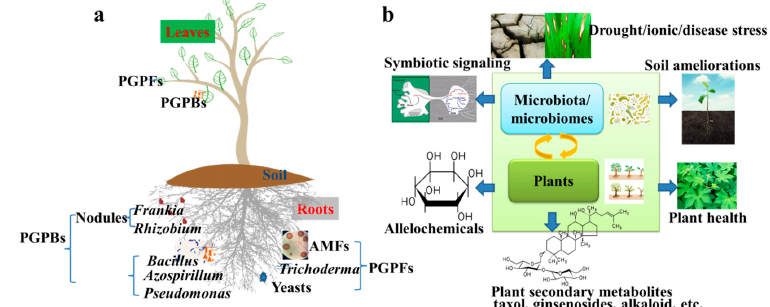
in rhizosphere, phyllosphere, and endosphere. Arbuscular mycorrhizal fungi (AMFs), Frankia spp. and Rhizobium spp. act as symbionts for plant roots; ( b ) Future research trends of microbiota and microbiomes associated with crop plants. PGPBs, plant growth-promoting bacteria; PGPFs, plant growth-promoting